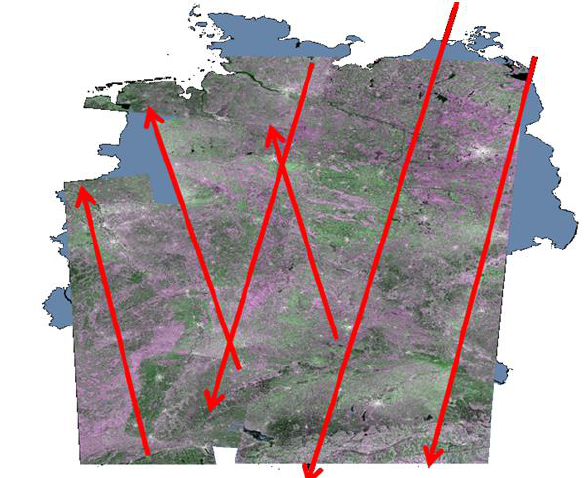
Figure 5. Sentinel-1 observation of Germany for several